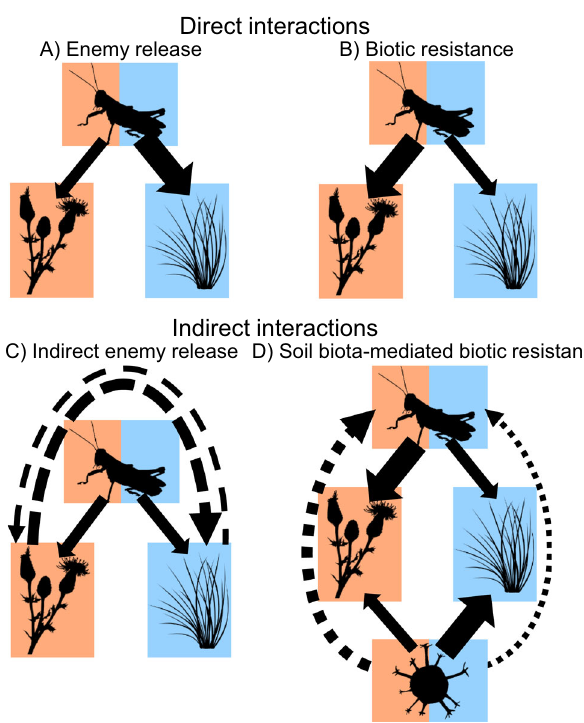
Fig. 1 Conceptual fi gure detailing the invasion hypotheses tested. A The enemy release hypothesis, predicting that exotic plants should bene fi t from weaker interactions with polyphagous herbivores relative to co-occurring native species; B the biotic resistance hypothesis, predicting that resident polyphagous herbivores should inhibit exotic plants more than natives; C indirect enemy release, predicting that exotic plants should have higher potential to exert and lower potential to receive apparent competition than native plants; and D soil biota-mediated biotic resistance, predicting that exotic plants should experience stronger interactions with herbivores when growing in soil communities containing specialist soil biota. See main text and Table 1 for additional details on hypotheses and predictions. Arrow width represents the relative strength of negative direct (solid line), negative indirect (dashed line) and positive indirect (dotted line) interactions, and panel colour represents native (blue), exotic (orange) or mixed (both colours) provenance of plants, herbivores and soil biota. Symbols courtesy of the Integration and Application Network (ian.umces.